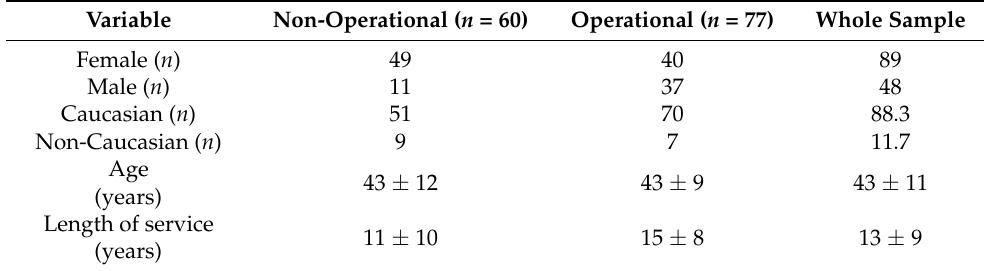
Table 1. Descriptive characteristics of the sample ( n = 137).